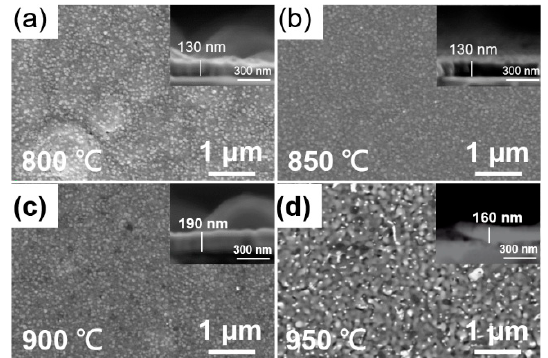
Figure 2. SEM images of the Mo x W 1 − x S 2 thin films by sulfurizing MoW alloy at different tempera- tures: ( a ) 800, ( b ) 850, ( c ) 900, and ( d ) 950 °C. The insertion in each figure is the corresponding cross sectional SEM image.